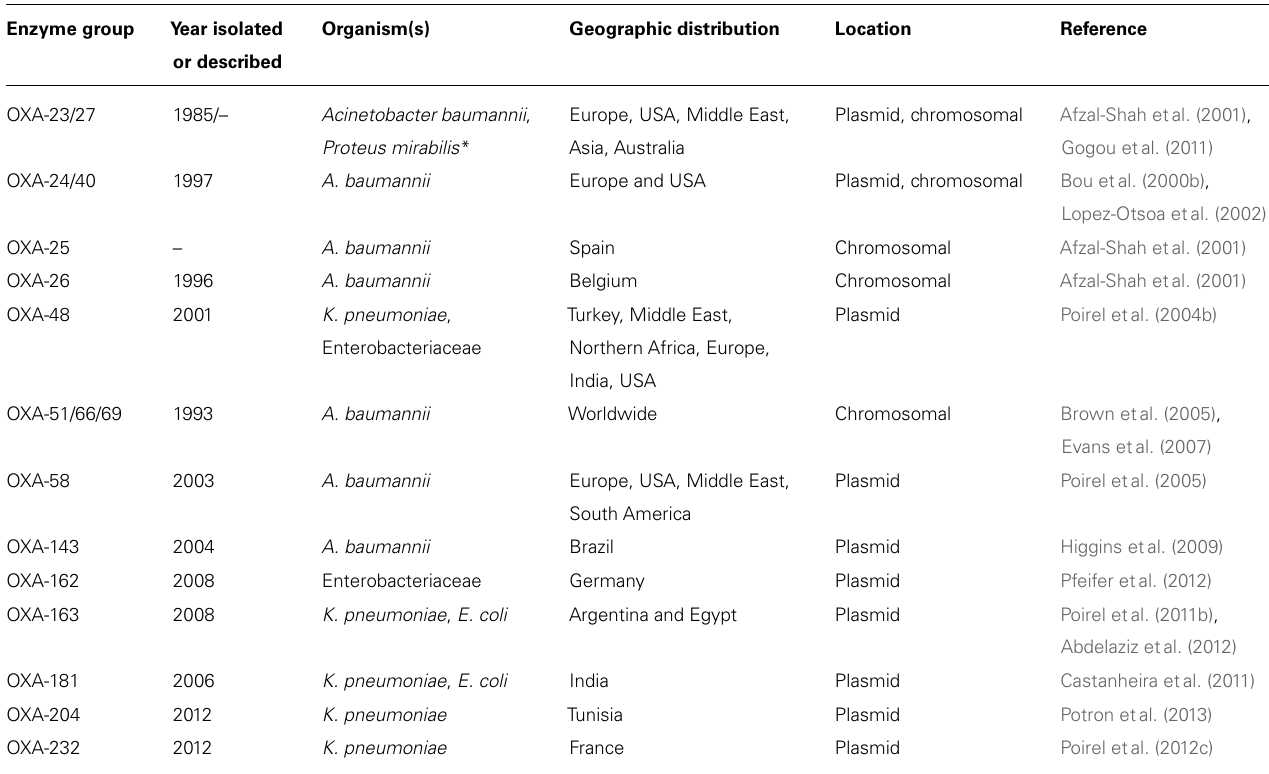
Table 3 | Carbapenem-hydrolyzing class D β -lactamases. Enzyme group Year isolated Organism(s) Geographic distribution or described